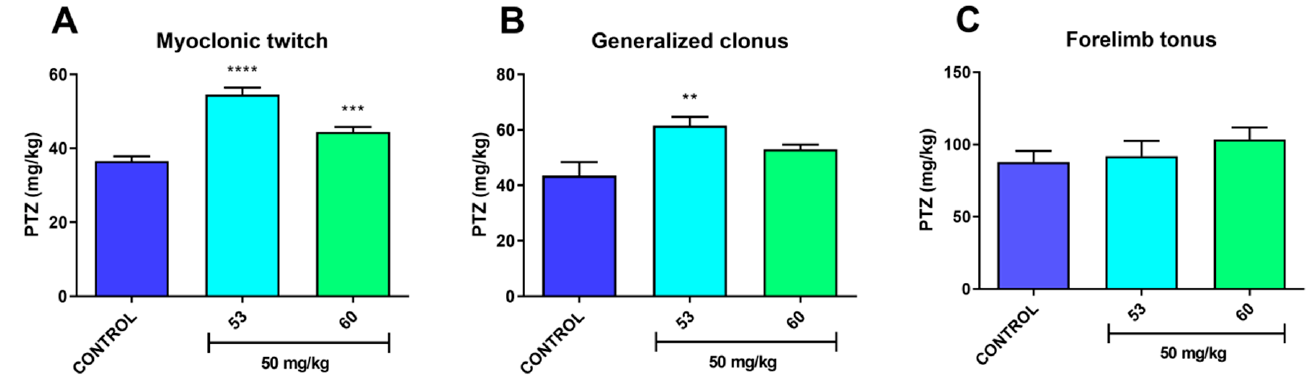
Figure 2. Acute effects of 53 and 60 on the threshold for the first myoclonic twitch ( A ), generalized clonus ( B ), and forelimb tonus ( C ) in the iv PTZ seizure threshold test in mice. Compounds 53 and 60 were administered i.p . 0.5 h before the seizure test. Control animals received vehicle only. Each experimental group consisted of 9–12 animals. Each bar represents the mean (mg/kg PTZ) + SEM. ** p < 0.01, *** p < 0.001, **** p < 0.0001 vs. the control group (Student’s t -test).